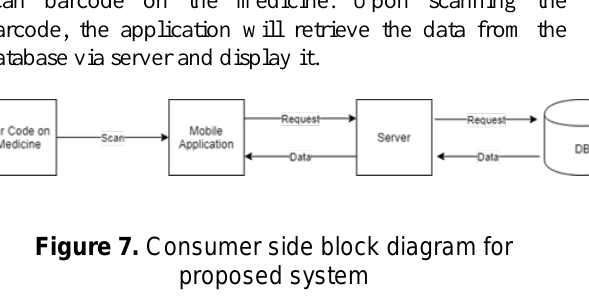
Figure 5. Architecture diagram of the proposed